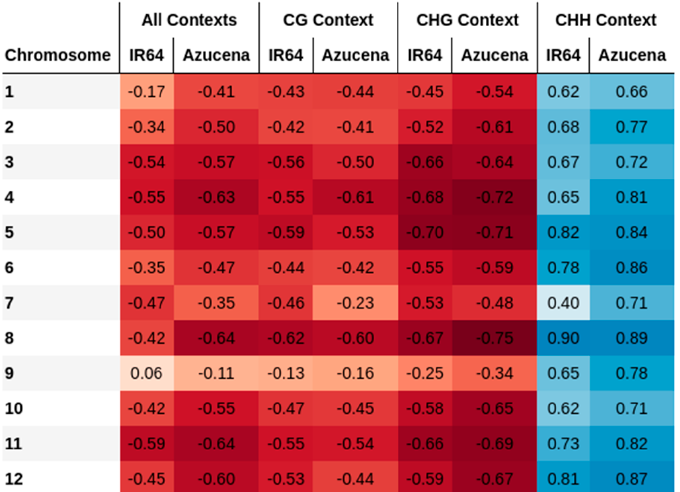
Figure 1. Recombination and methylated cytosines through Chromosome 1 for the rice varieties IR64 and Azucena. The centromere is represented by a red dotted line and the influence of the cen- tromere region by solid red lines.